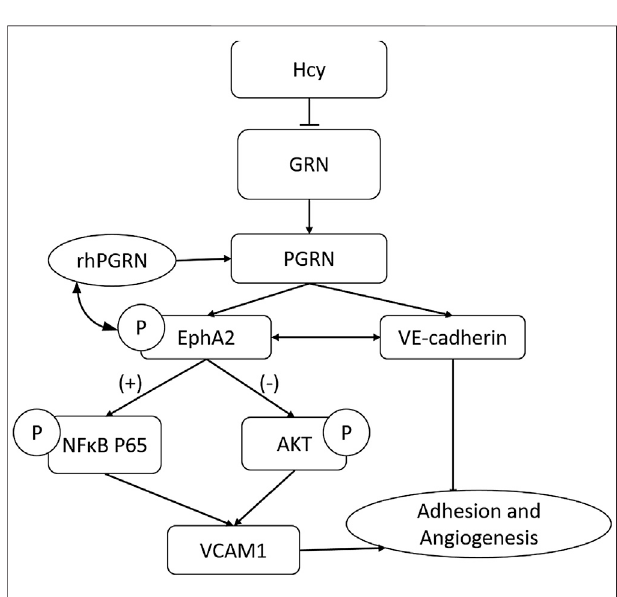
FIGURE 8 | The PGRN/EphA2 axis might be one of the primary mechanisms by which Hcy impairs endothelial adhesion and angiogenesis.